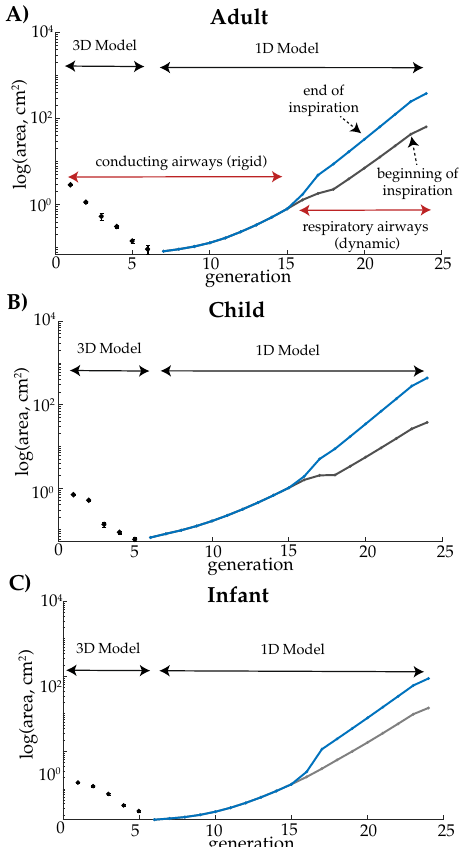
Figure 2. Cross-sectional areas of representative branches in the lower left lobe of the adult (panel A ), child (panel B ), and infant (panel C ) models. Note, for the outlined 3D regions, the areas are measured directly from the image-based models (error bars represent the standard deviation of the airways within each generation). The 1D regions are idealized and scaled to match FRC (Table 2). The conducting and respiratory zones are highlighted in panel ( A ), where the blue and gray lines represent the total cross-sectional area at the end and beginning of inspiration,